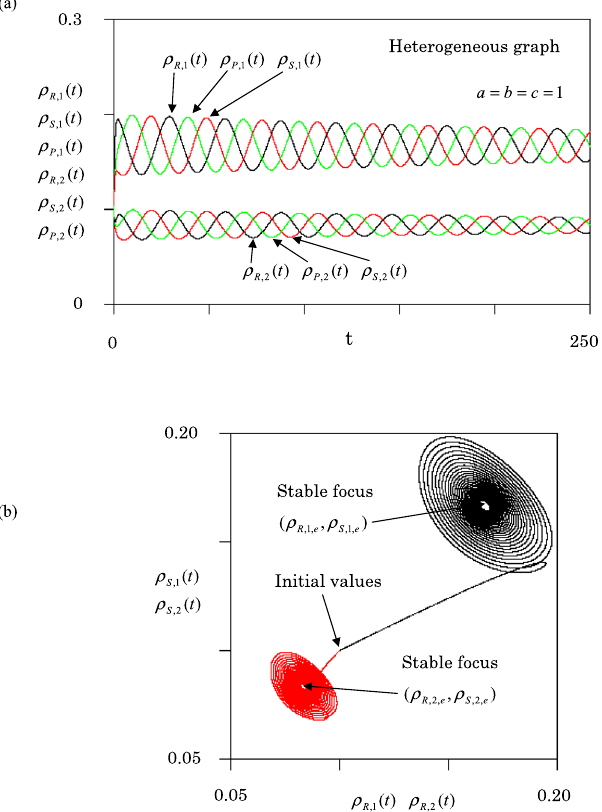
Figure 4. Results of population dynamics for heterogeneous graph [Fig. 1(b)] at rate = = = a b c 1 . ( a ) Three (R, S, P) densities in nodes 1 and 2 are depicted against time t . ( b ) Two orbits are displayed. (i) the black orbit: ( ρ t ( ) , ρ t ( ) ) in node 1, and (ii) the red orbit: ( ρ t ( ) S ,1 R ,1 Fig.